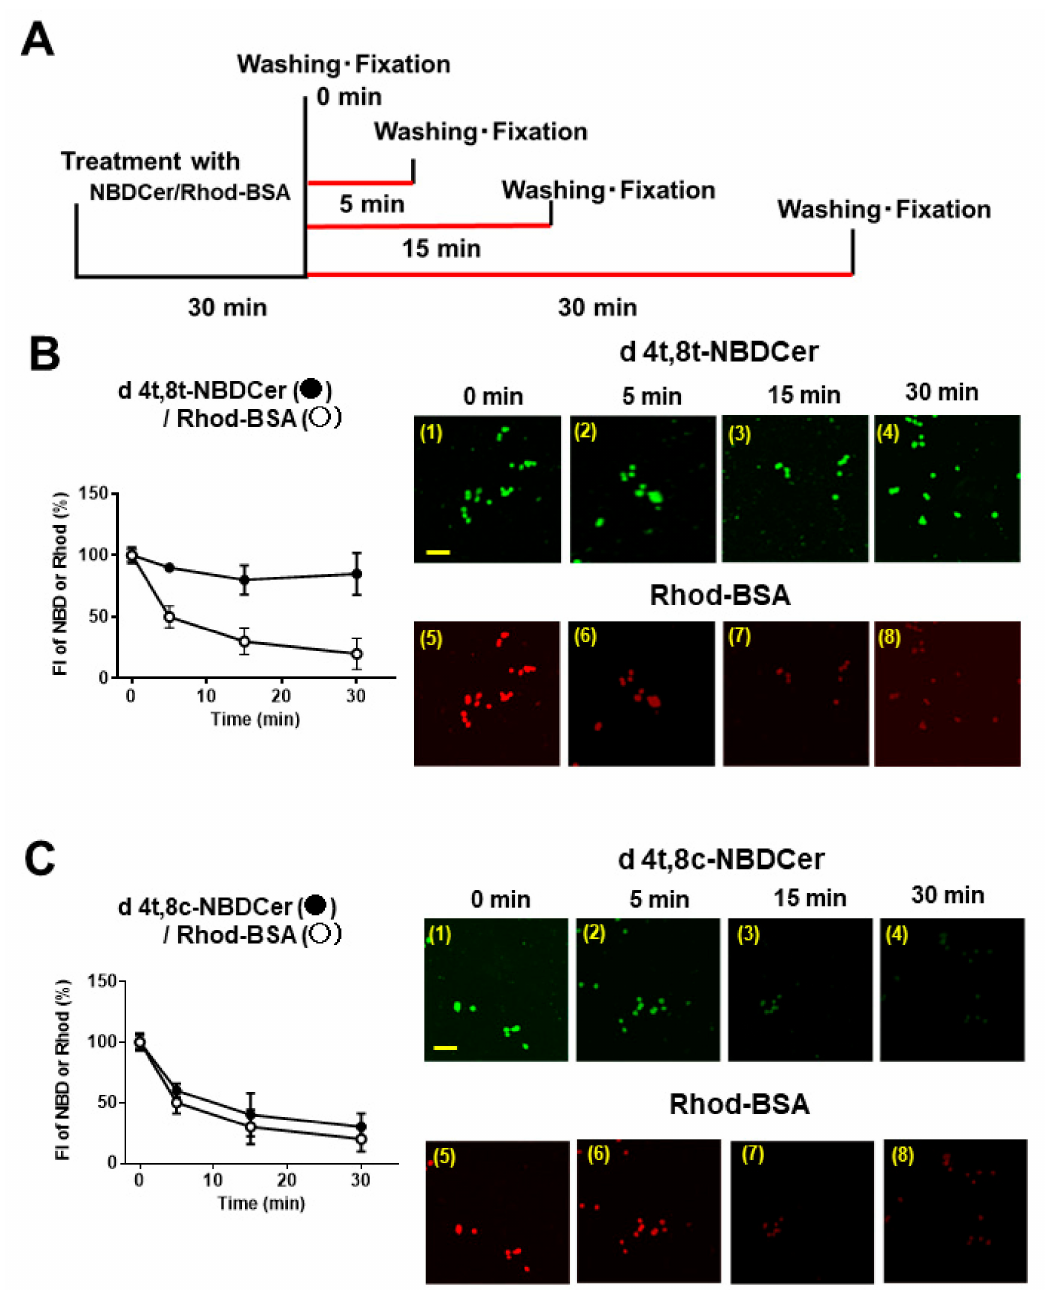
Figure 5. Time course of NBD-Cer and Rhod-bovine serum albumin (BSA) bound to PC12 cells. ( A ) Dissociation time course analysis of FI based on binding of 100 nM d NBD-Cer (FI = 5000) and 100 nM Rhod-BSA (FI = 5510), examined using Plexin A1 gene-silencing PC12 cells. ( B ) Images showing (1 to 4) changes in d4t,8t-NBD-Cer and (5 to 8) changes in Rhod-BSA at the indicated timepoints. The left graph shows a time course plot of FI (%) relative to 0 min. Data are presented as mean ± SD ( n = 3). Scale bar = 100 µ m. ( C ) Images showing (1 to 4) changes in d4t,8c-NBD-Cer and (5 to 8) changes in Rhod-BSA at the indicated timepoints. The left graph is a time course plot of FI (%) relative to 0 min. Data are presented as mean ± SD ( n = 3). Scale bar = 100 µ